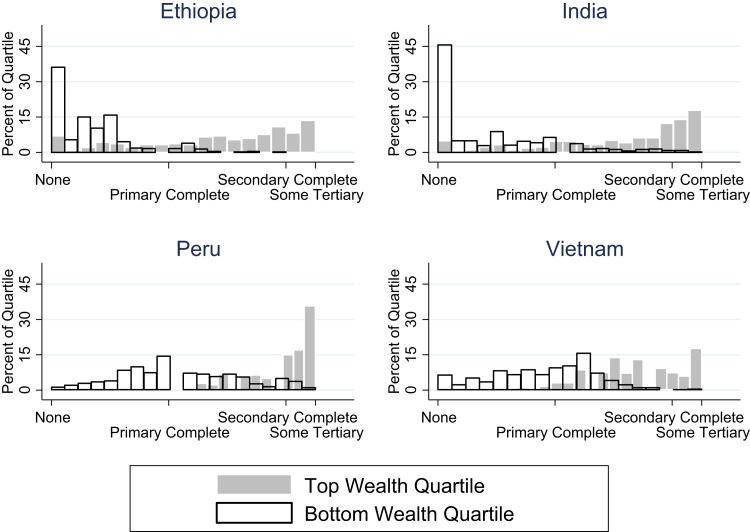
Densities of Average Parental Schooling by Wealth Quartile.